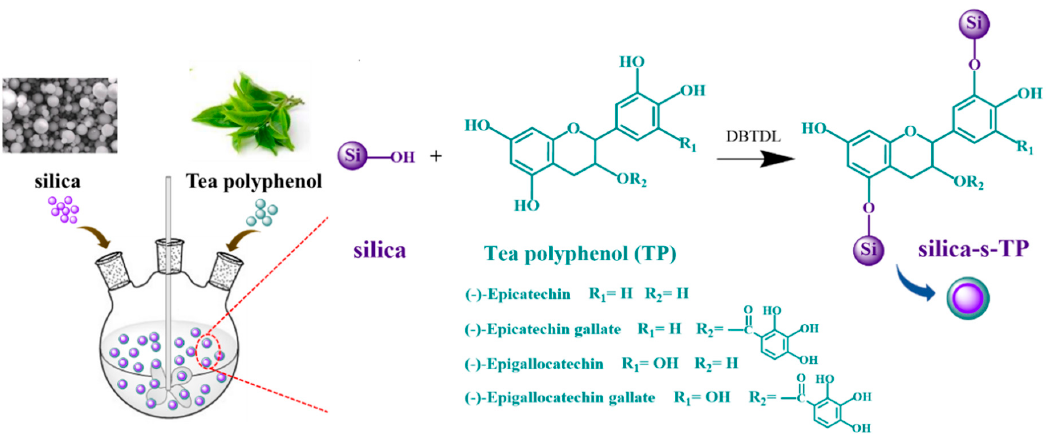
Figure 1 . The synthesis route of silica-s-TP. Figure 1. The synthesis route of silica-s-TP.